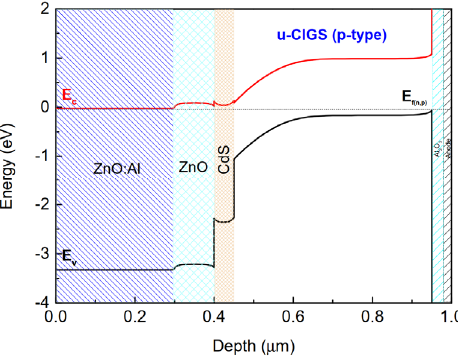
Figure 1. Structure of 2D passivated u-CIGS solar cell model.